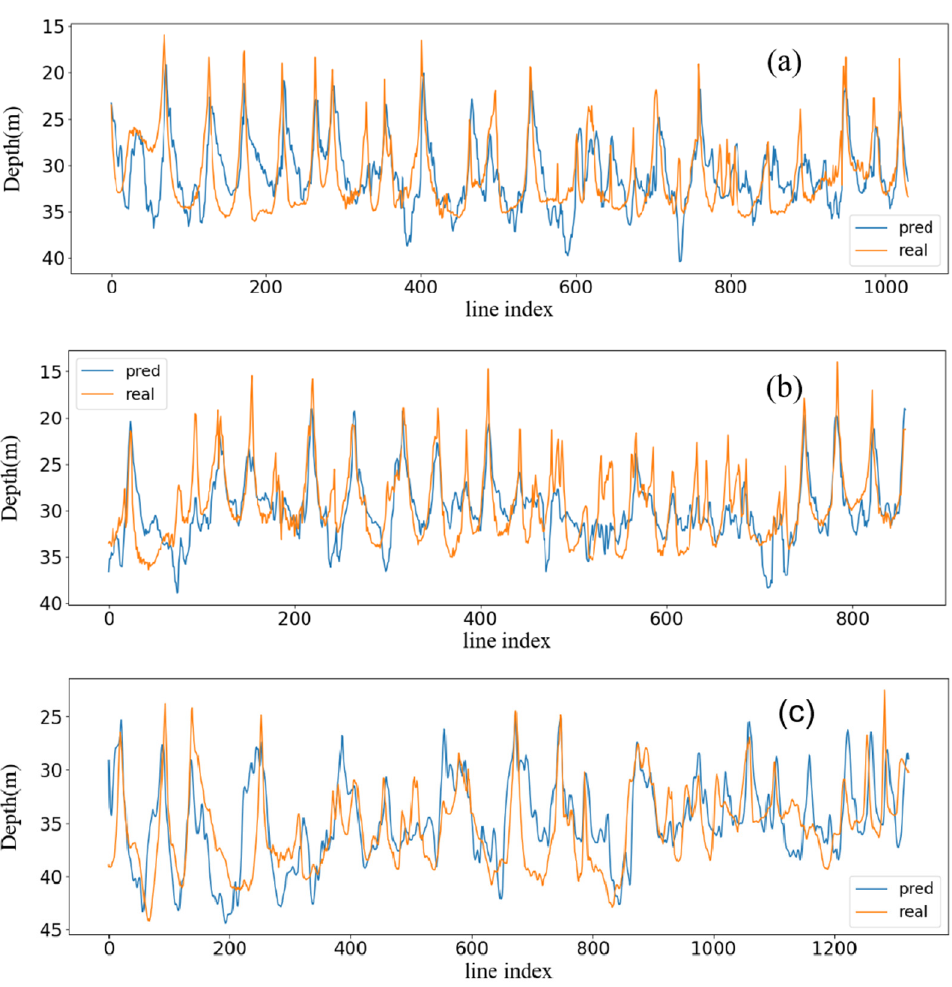
Figure 13. Sections of areas ( a ) A2, ( b ) A3, and ( c ) A4.